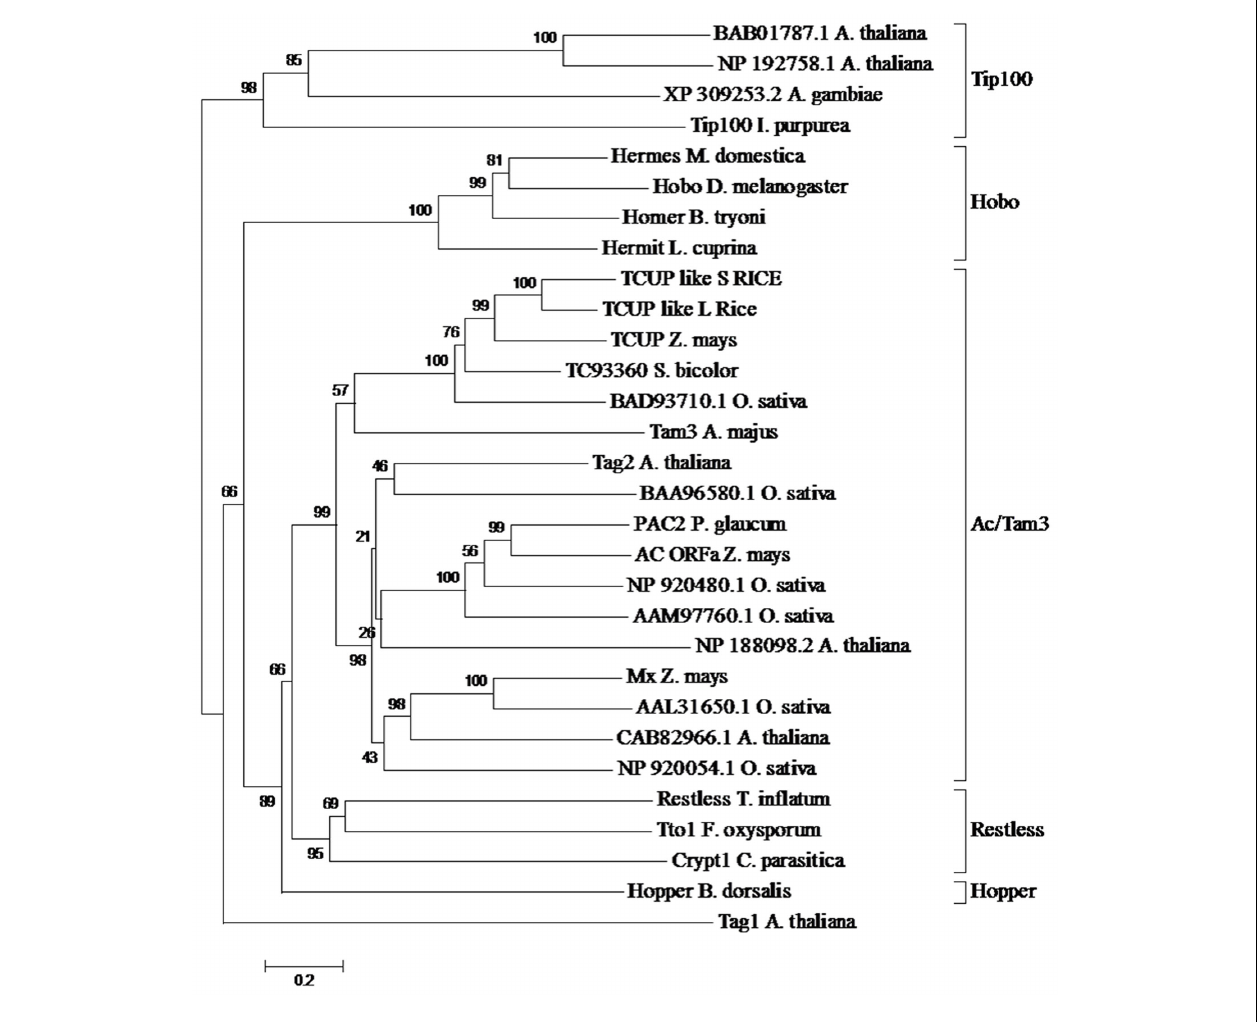
transposases are marked with brackets.The values in each bracket represent percentage of times the clade is present among 1000 bootstraps.